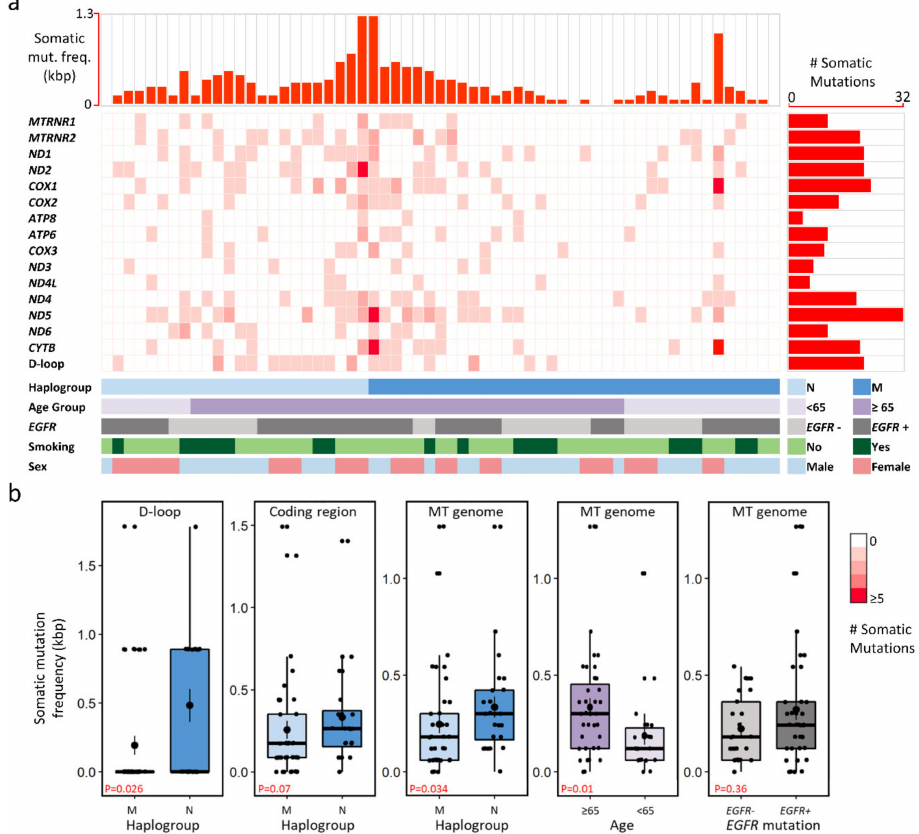
Figure 2. Somatic mutations identified in stage I LUAD patients. ( a ) Profile of mitochondrial somatic mutations; each column and row represent a sample and mitochondrial gene, respectively. The color intensity corresponds to the mutation count in a particular sample. ( b ) Somatic mutation frequency (per kbp) in mitochondrial genomic regions with respect to haplogroup, age, and EGFR -activating mutation status. Abbreviations- EGFR + : patients harboring EGFR -activating mutations, EGFR − : patients without EGFR -activating